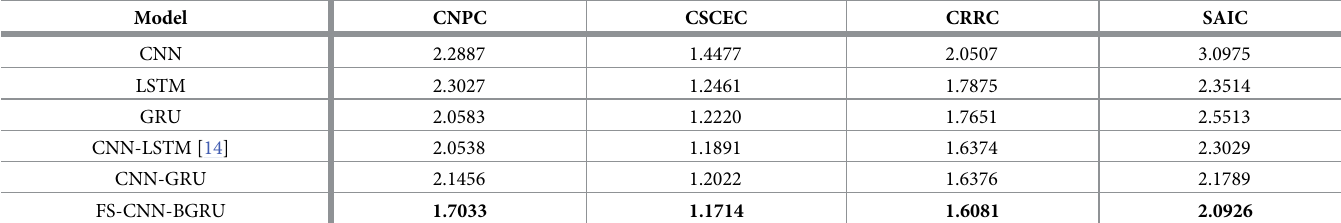
Table 12. MAPE value of common stock (%).